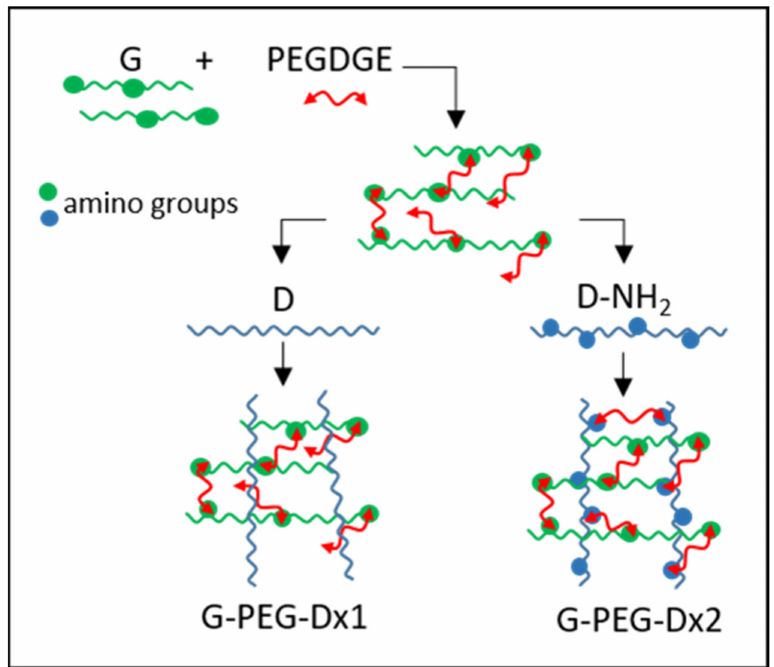
Scheme 1. Hybrid hydrogels network. Schematic representation of the network formations of hybrid hydrogels G-PEG-Dx1 and G-PEG-Dx2.